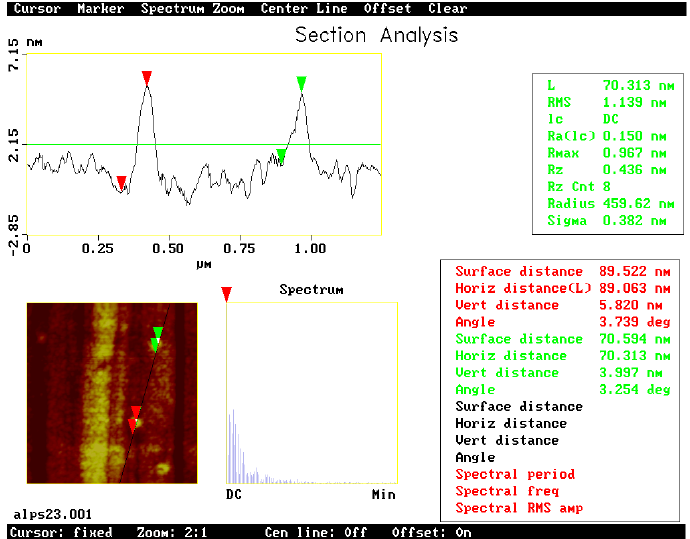
Figure 8. AFM image of the pole area of the magnetic head.